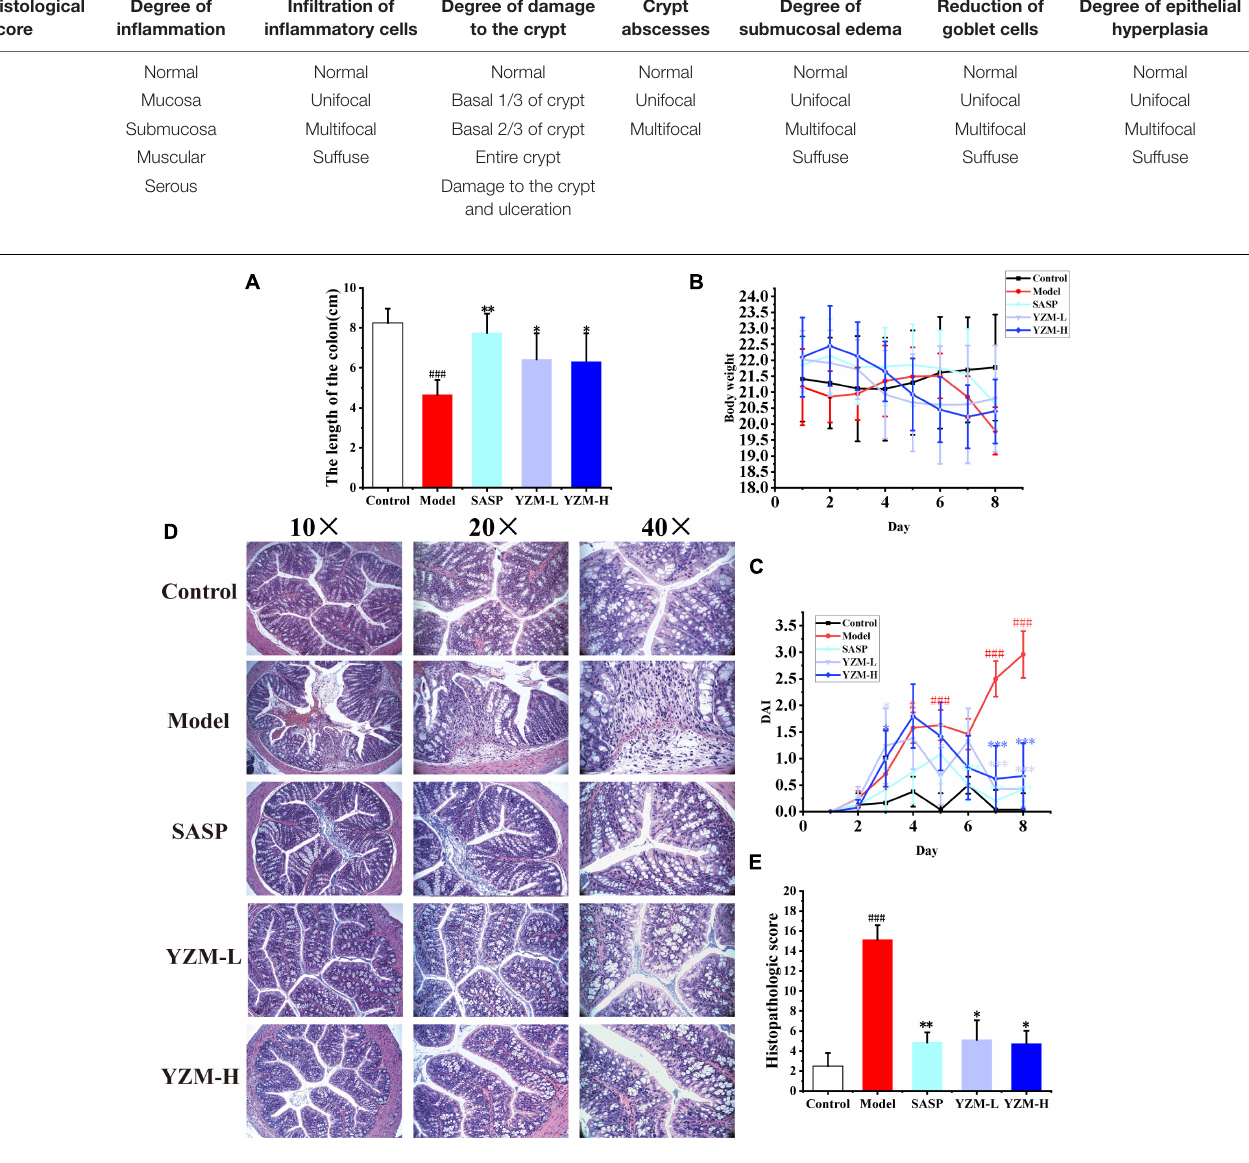
Frontiers in Nutrition |